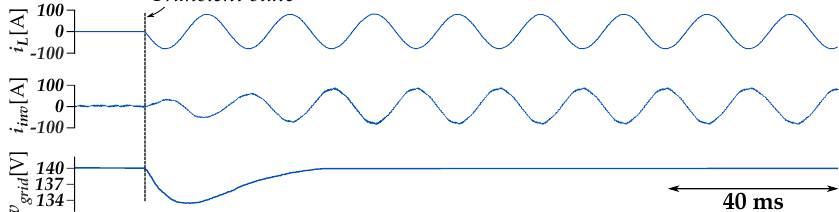
Figure 16. Confirming the effectiveness of the total voltage control and swapping technique with capacitor voltage control. ( a ) Simulated waveforms when the total voltage control is active and swapping technique is initially intentionally inactive. ( b ) Experimental waveforms when both total voltage control and capacitor voltage control remain active.